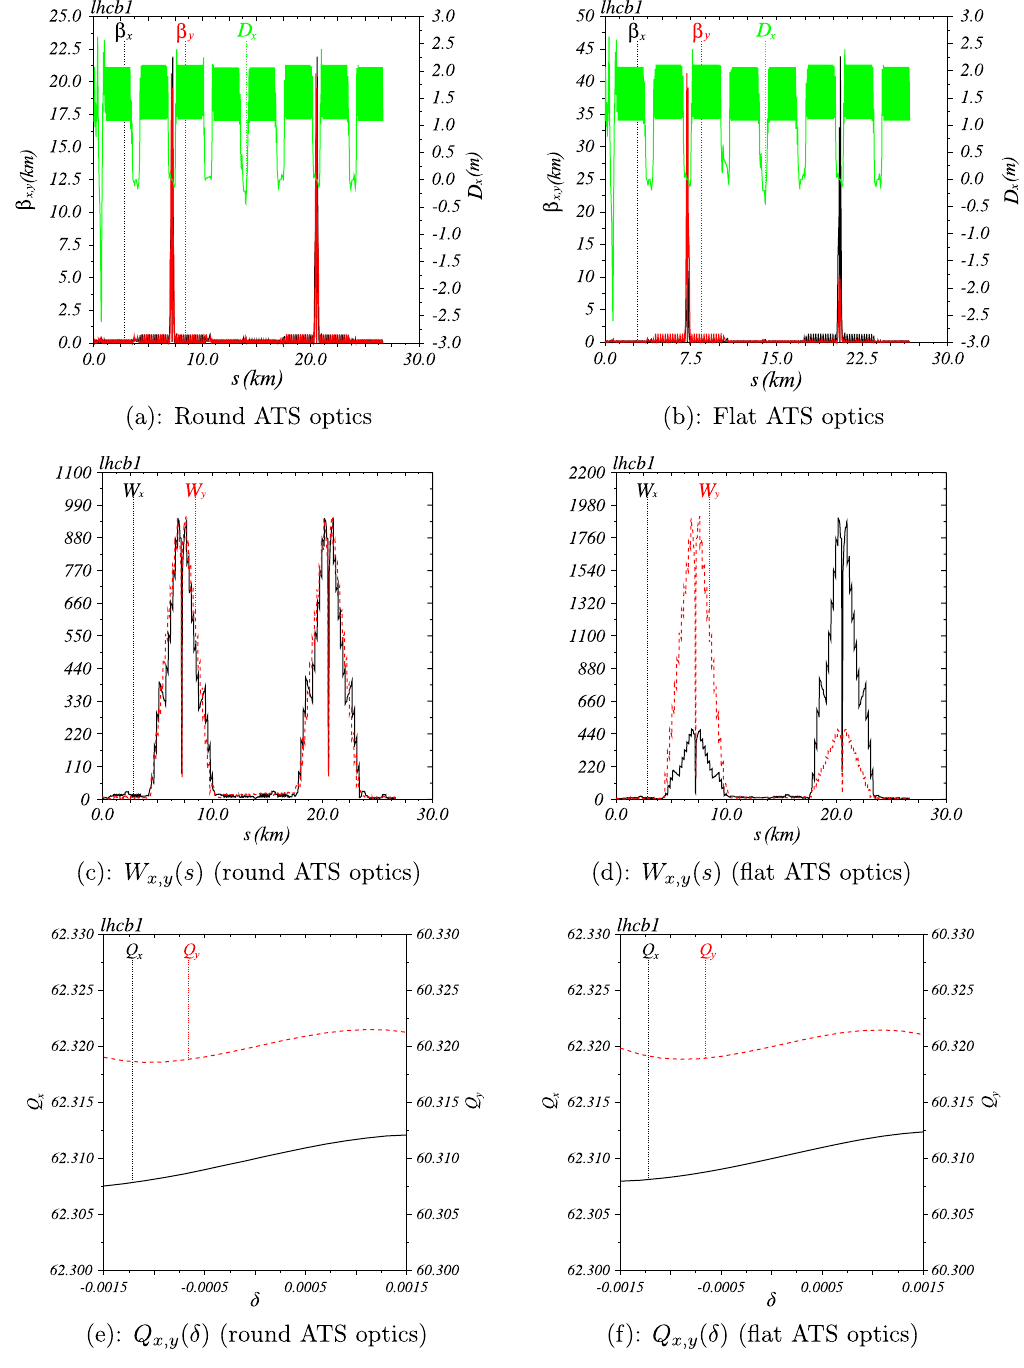
FIG. 9. Typical round (left pictures) or flat (right pictures) telescopic optics for the HL-LHC, with (cid:1) (cid:1) x;y ¼ 10 cm in both planes at IP1 and IP5, or (cid:1) (cid:1) x;y ¼ 5 = 20 cm (respectively 20 = 5 cm ) at IP1 (respectively IP5). The machine is cycled from IP3: comparison in terms of (cid:1) and dispersion functions [(a) and (b)], Montague functions [(c) and (d)], and chromatic variations of the betatron tunes [(e) and (f)]. The crossing scheme has been switched off in the four experimental IRs in order to preserve the dispersion matching (see also Sec. III